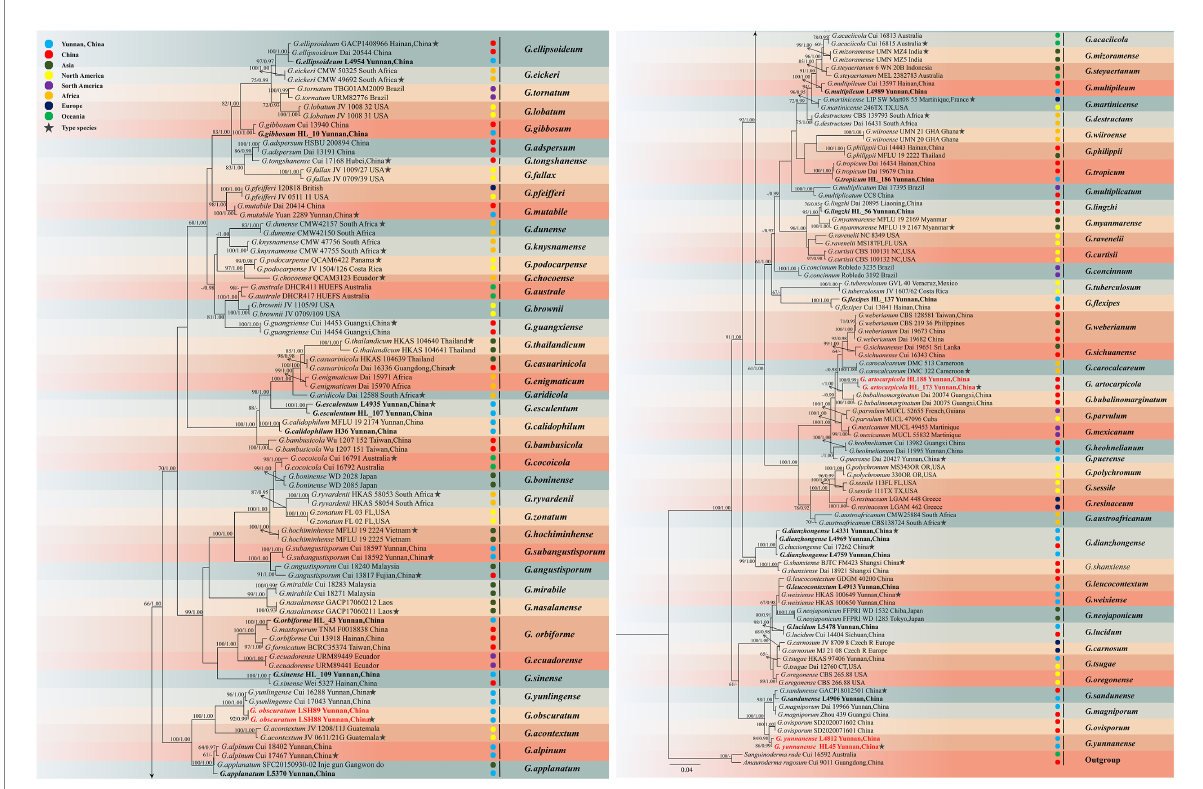
FIGURE 3 Maximum likelihood (ML) tree generated from a combined ITS + nrLSU + TEF1- α + RPB2 sequence dataset. Bootstrap support values with a maximum likelihood (ML) equal to or greater than 60% and Bayesian posterior probabilities (PP) equal to or greater than 0.90 given above the nodes as “ML/PP.” New collections are indicated in black bold while new species are in red